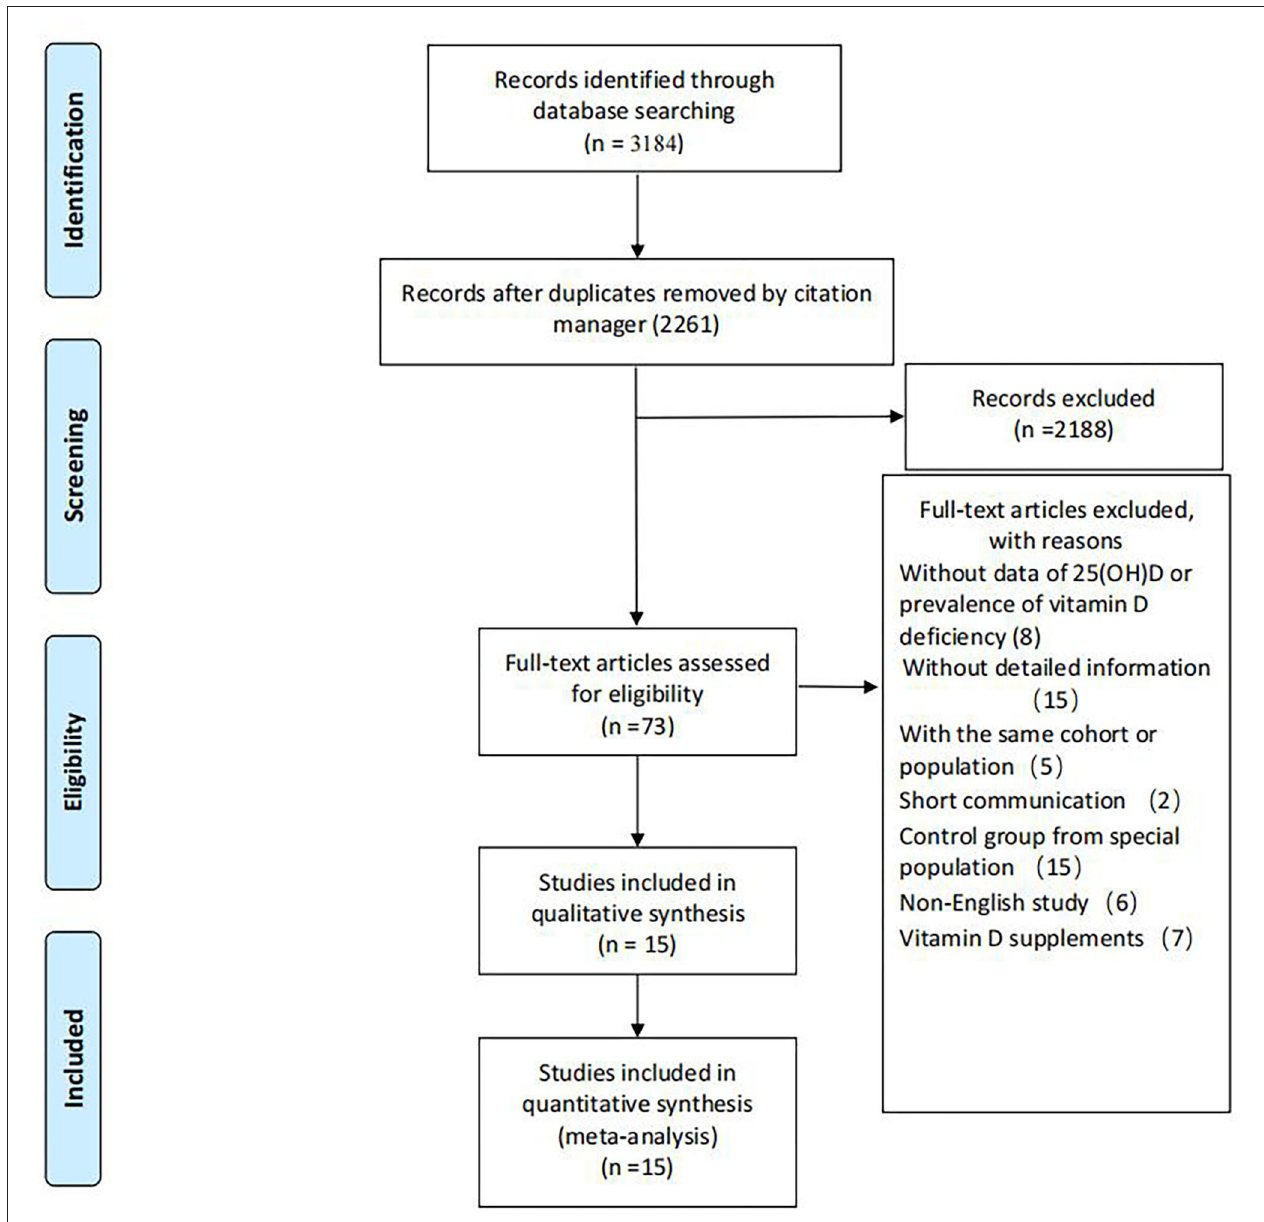
FIGURE 1 | Flowchart of the studies included in the meta-analysis.